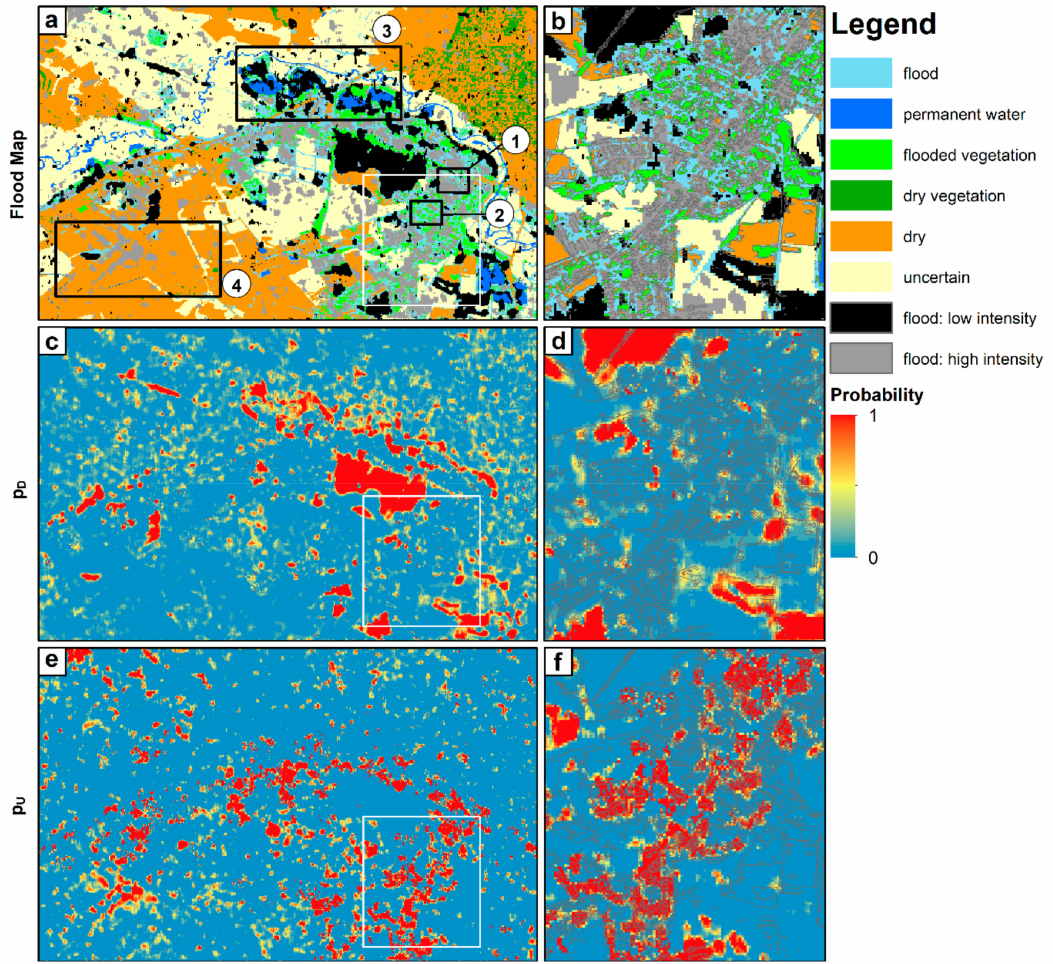
Figure 6. Flood mapped by the probability threshold of p = 0.5 for ( a ) the whole area of interest (AOI) and (b) the urban area. The second and third panels are for the probability maps of ( c – d ) intensity decrease ( p D ) and ( e – f ) intensity increase ( p U ). Numbers in white circles are the patch IDs used in